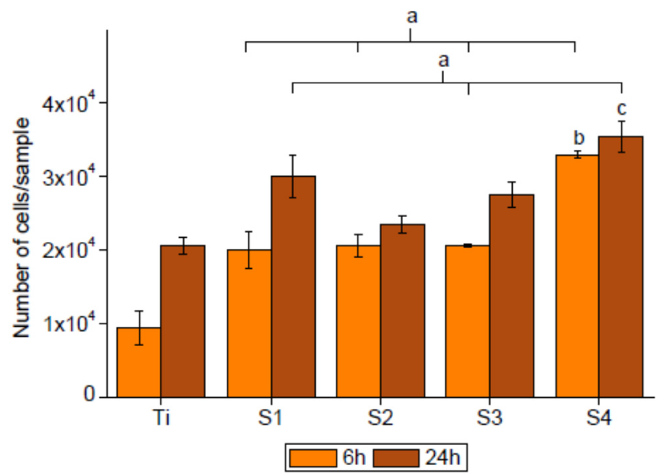
Figure 11. Adhesion of hFFs on the plasma-polymerized, HEMA-coated samples. For each time point, a indicates statistically significant differences compared with Ti, b compared with S1, S2 and S3 and c compared with S2 and S3 ( p < 0.05).